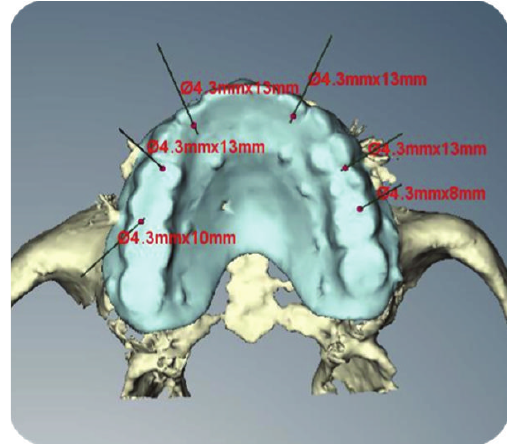
Figure 2: Virtual implant planning. Occlusal view.